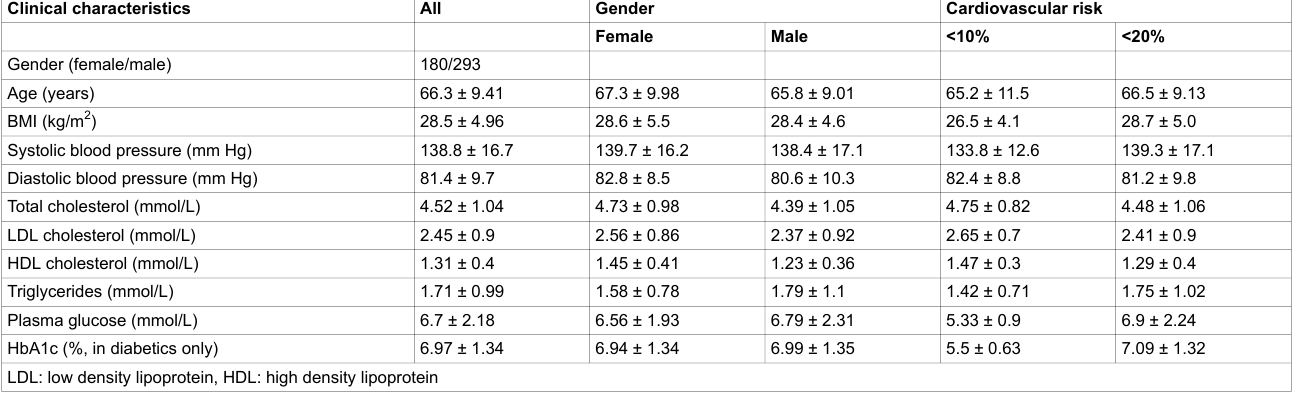
Table 1: Baseline characteristics of the study population.